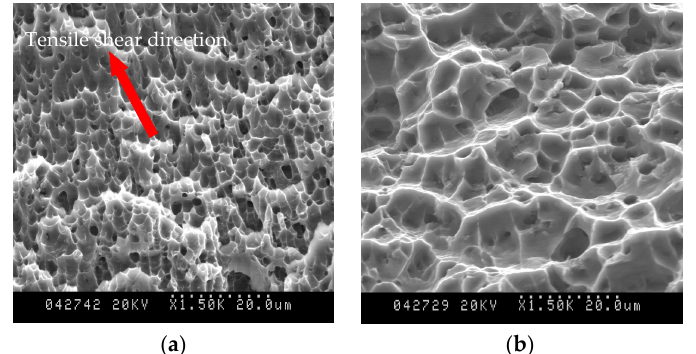
Figure 9. Scanning electron microscopy (SEM) images showing the fracture morphology of the failed specimens: ( a ) failed across the faying surface; ( b ) failed in the weld of the skin.